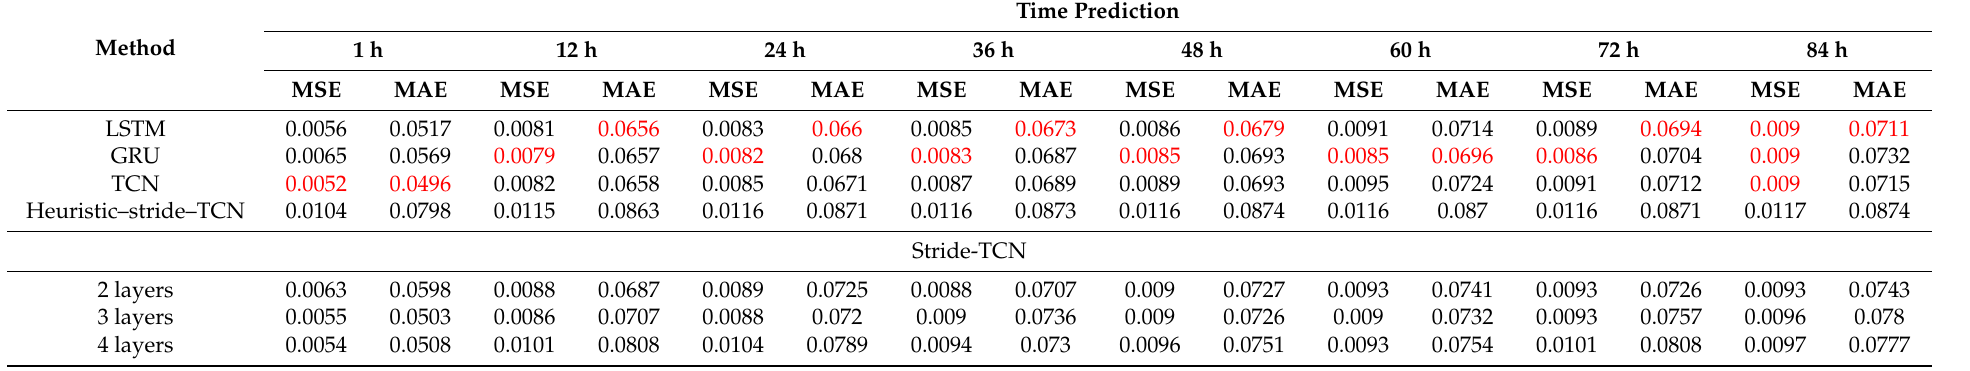
Table 7. Performance (MSE and MAE) of all models on the Household dataset.